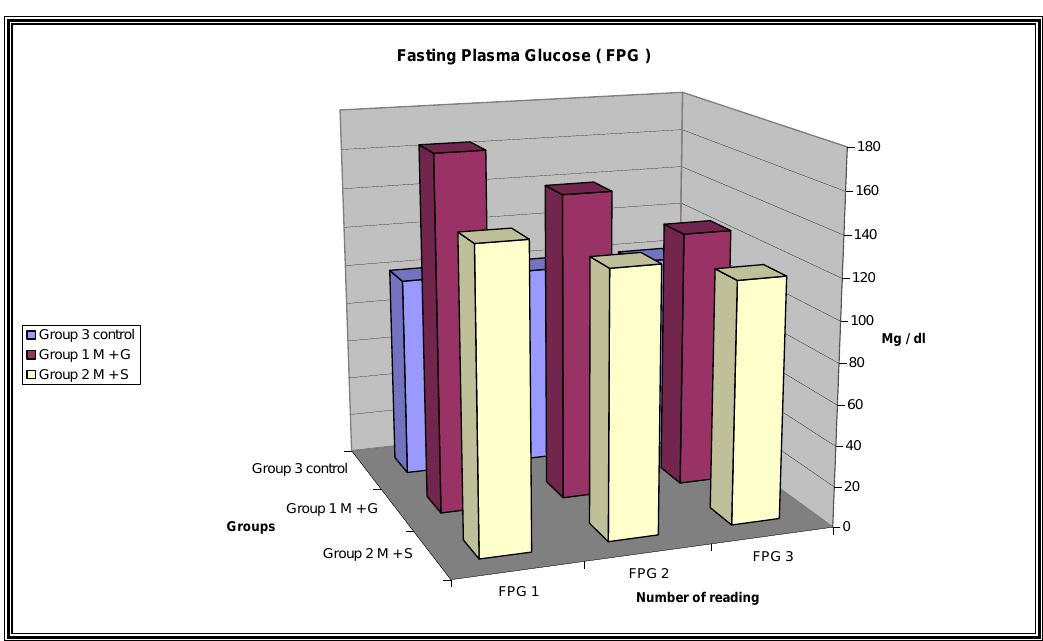
Figure 1: Histogram showing effect of treatment with metformin 500 mg 3 times daily + glibenclamide 5 mg twice daily group 1 versus metformin 500 mg 3 times daily + sitagliptin 100 mg once daily group 2 on FPG in patients with T2DM and group 3 control normal healthy subjects after 1,3 and 6 months of treatment.( n = 34 individuals for each group)